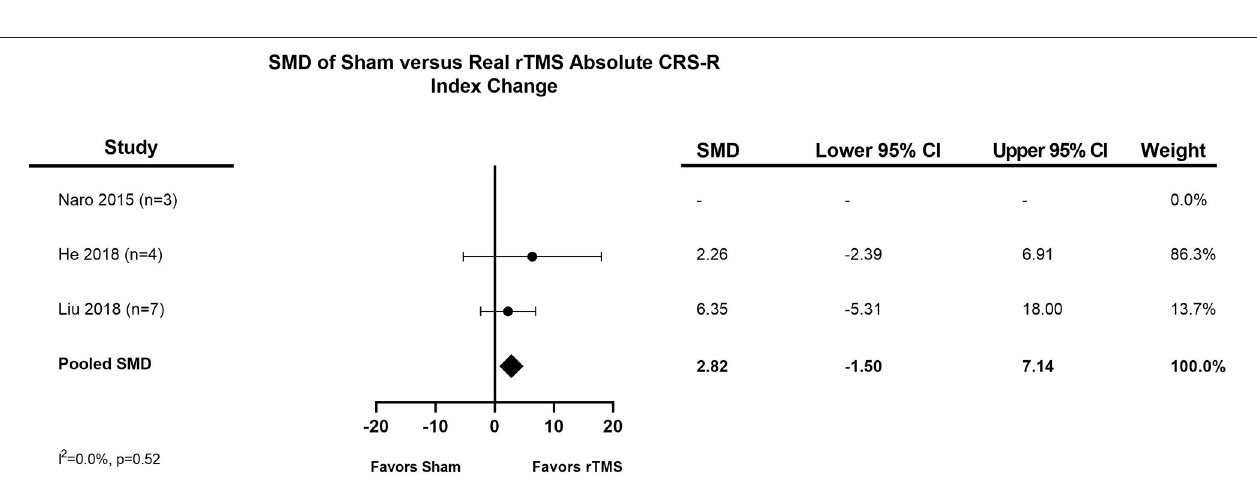
FIGURE 3 | Meta-analysis of IPD: pooled mean absolute CRS-R index change from baseline to last Post-TMS CRS-R assessment. A positive SMD (pooled mean absolute change toward the right of the figure) favors a positive effect for TMS, while a negative SMD (pooled mean absolute change toward the left of the figure) favors no effect or a negative effect for TMS. CI, Confidence Interval; CRS-R, Coma Recovery Scale-Revised; DoC, Disorder of Consciousness; SMD, standardized mean difference; TMS, Transcranial magnetic stimulation.